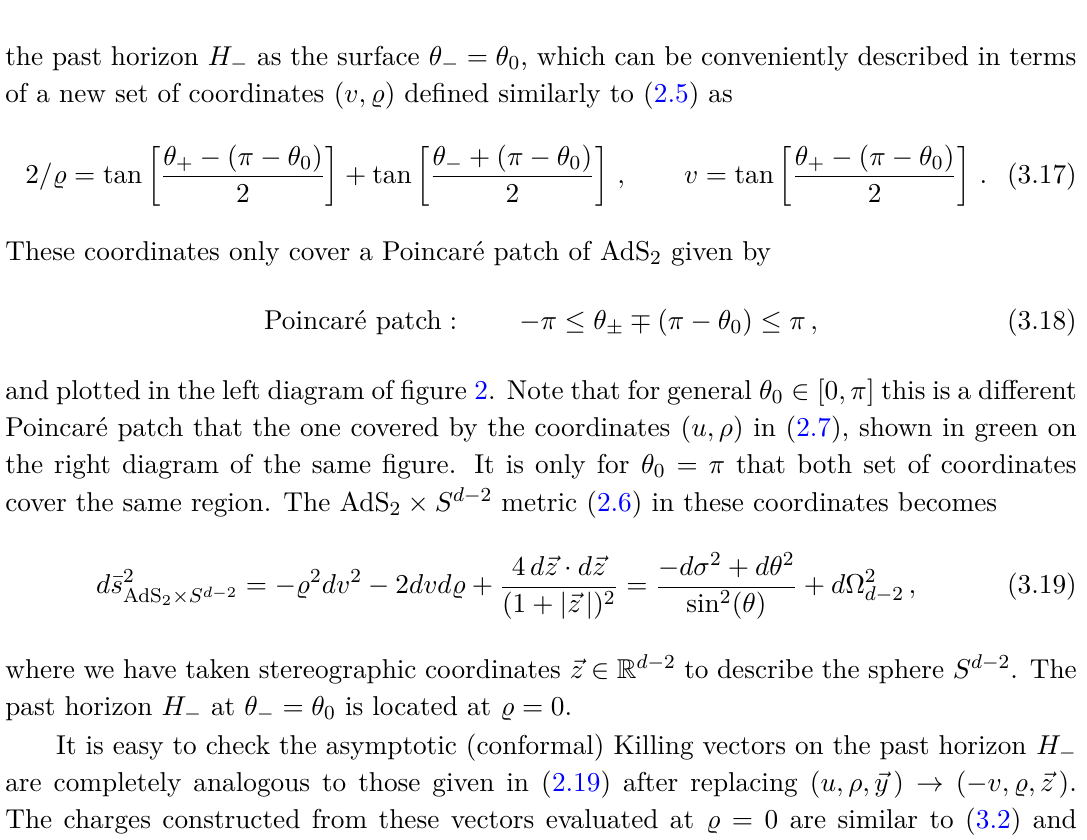
Figure 2 . On the left we have the region of AdS 2 covered by the coordinates ( v, % ) defined in (3.17). The past horizon (marked in red) is obtained as % = 0 and v ∈ R . On the right we plot the region of AdS 2 covered by the coordinates ( u, ρ ) and ( v, % ) in green and red respectively. The CRT transformation in (3.23) gives a map between these regions, most importantly mapping between the horizons H + ↔ H −